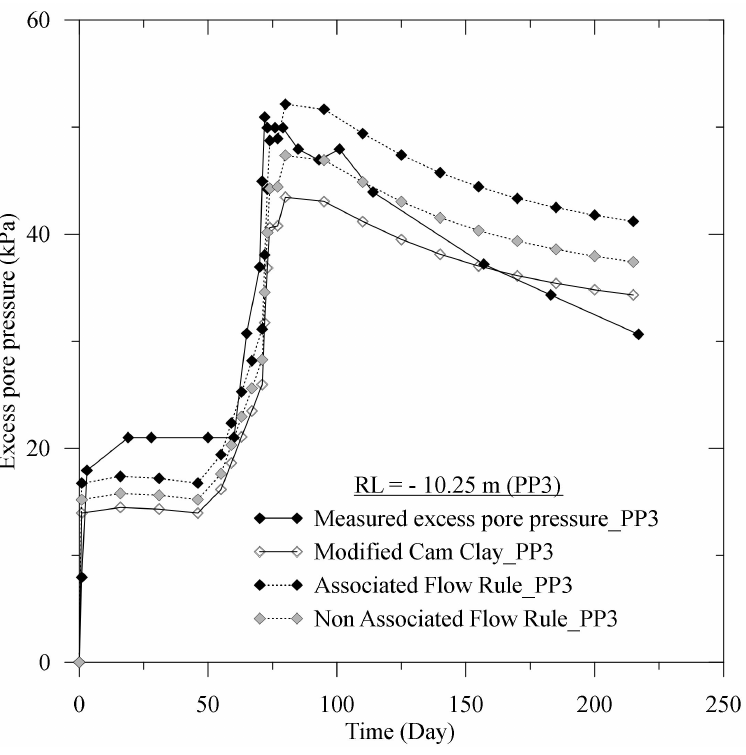
Figure 25. Observed and the predicted excess pore pressure at RL = –10.25